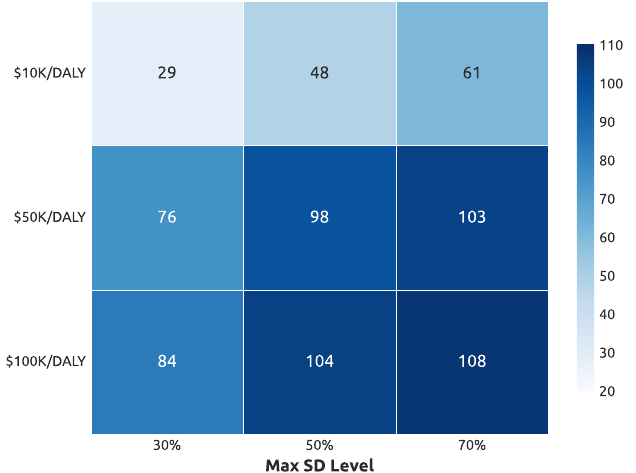
Figure 3. Cumulative Net Health Benefit (NHB) generated by adaptive NPIs, evaluated in the space of two threshold parameters: maximal SD level SD max and willingness-to-pay (WTP) threshold. NHB values shown in each cell are the mean values produced over approximately 14,000 simulations.